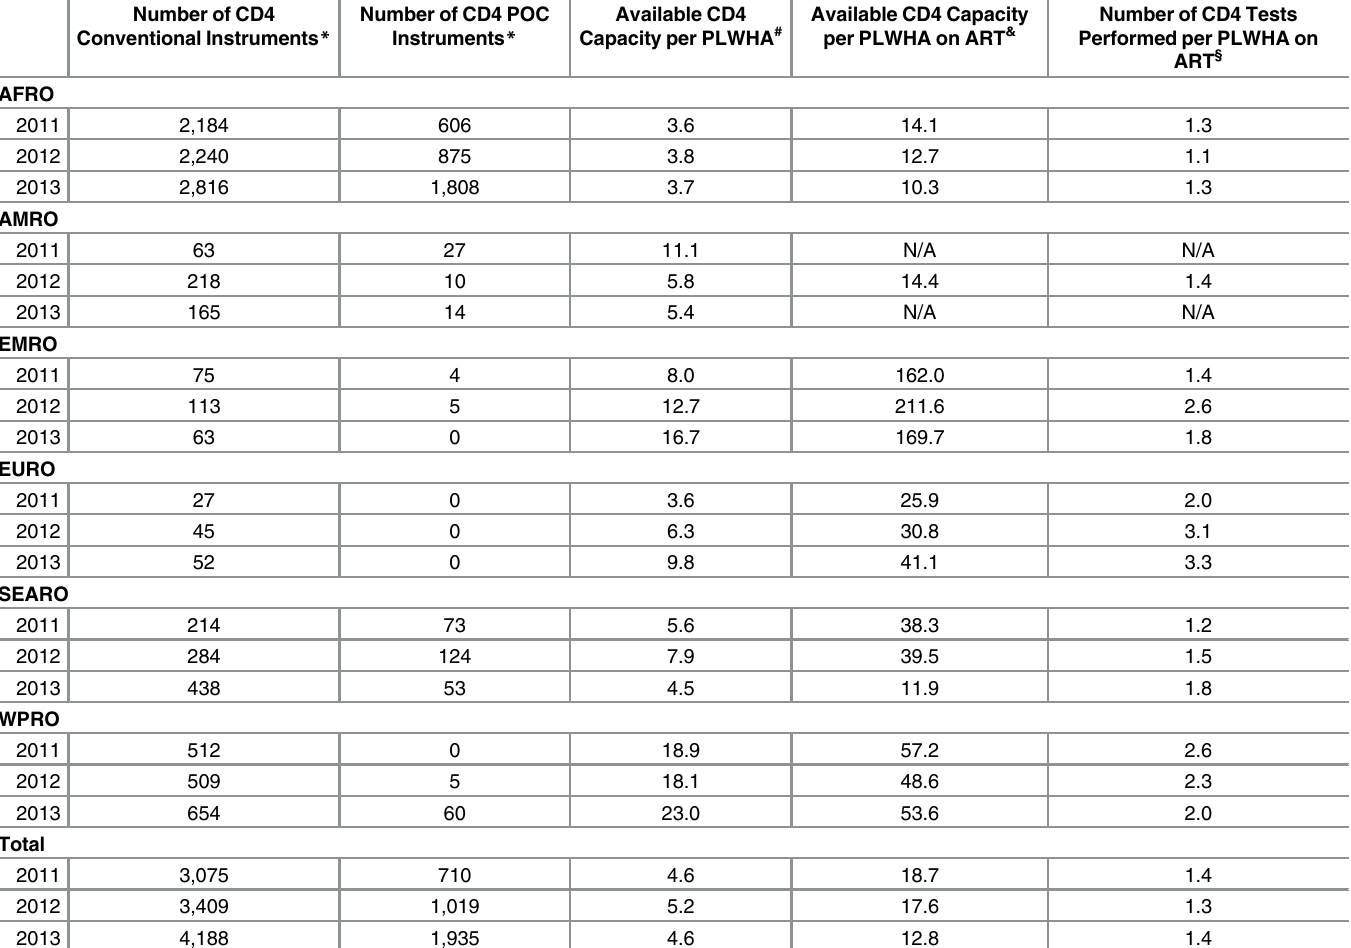
AFRO, WHO African region; AMRO, WHO Region of the Americas; ART, antiretroviral therapy; EMRO, WHO Eastern-Mediterranean region; EURO, WHO European region; N/A, data not available; PLWHA, people living with HIV/AIDS; POC, point of care; SEARO, WHO South-East Asian region; WPRO, WHO Western Paci fi c region. * Based on a subset of 69, 74, and 71 countries reporting the number of instruments in 2011, 2012, and 2013, respectively. # Based on a subset of 66, 71, and 68 countries with data available for number of instruments and number of PLWHA in 2011, 2012, and 2013, respectively. & Based on a subset of 54, 72, and 57 countries with data available for number of instruments and number of PLWHA on ART in 2011, 2012, and 2013, respectively. § Based on subset of 44, 50, 46 countries with data available for number of CD4 tests and number of PLWHA on ART in 2011, 2012, and 2013, respectively.